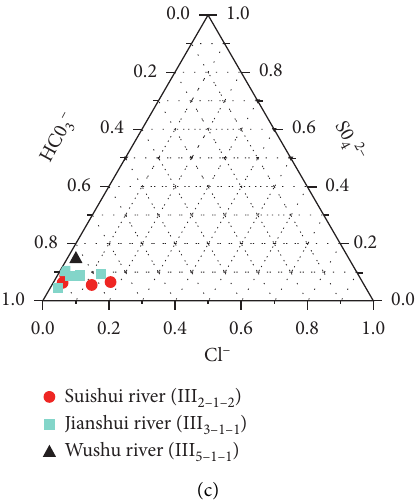
Figure 3: The water chemical pipe triple-variation figure of Northwest Xingguo County.